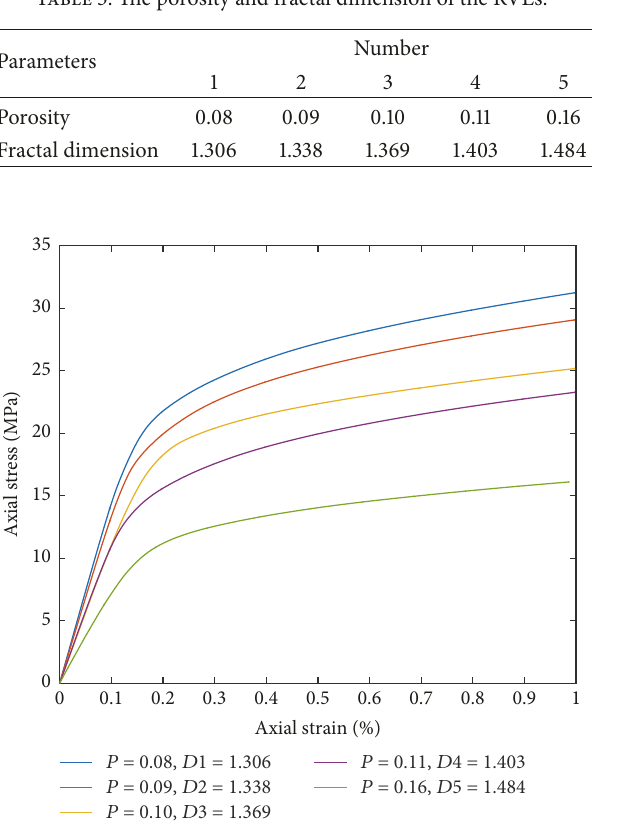
Figure 7: The stress-strain curves at different porosities when the fractal dimension difference is